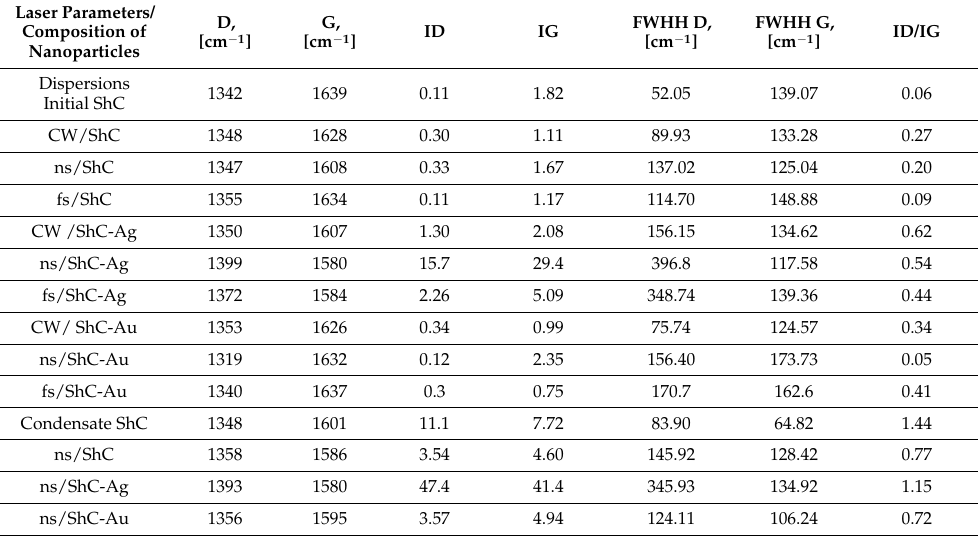
Table 2. Parameters of Raman spectra of nanoparticles in dispersions and of the condensed films. Laser Parameters/ Composition